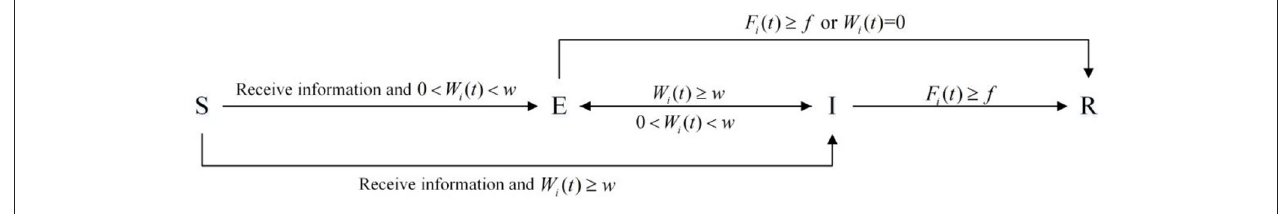
FIGURE 3 | Individual state transition